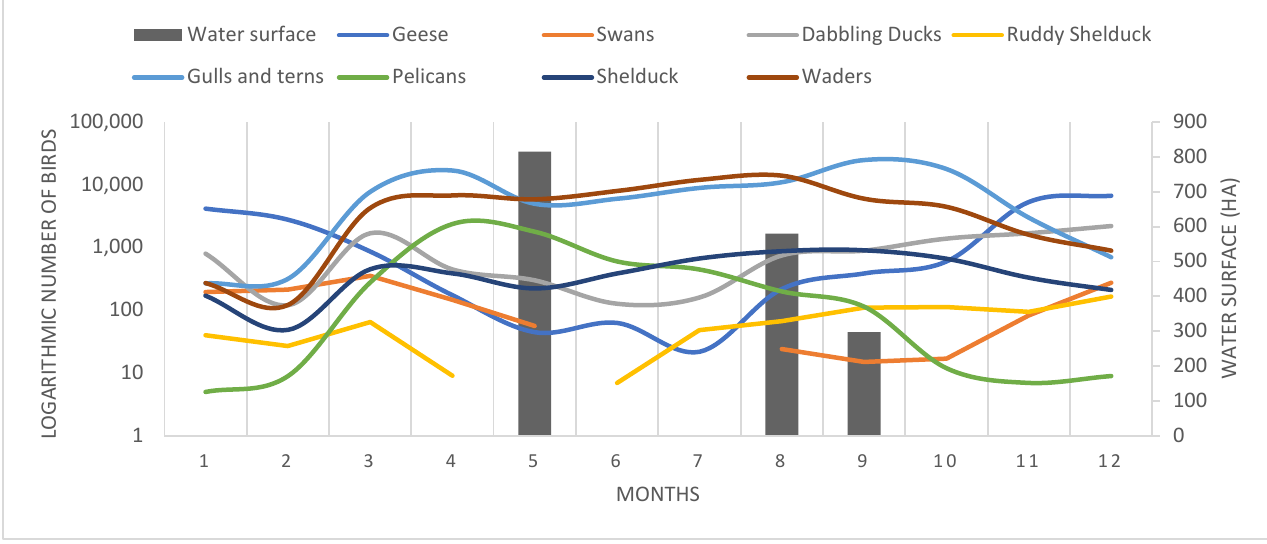
Figure 5. Average number of birds per the months in 2013.